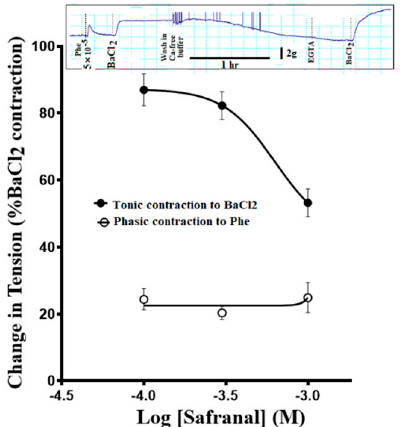
Figure 5. The phasic contractions induced by phenylephrine in a Ca 2+- free buffer (open circles) are not affected by safranal, whereas contractions induced by 3 × 10 − 2 M BaCl 2 (closed circles) are inhib- ited by increasing safranal concentration. Inset in the upper part of the figure represents a sample experiment for clarification. n = 6.